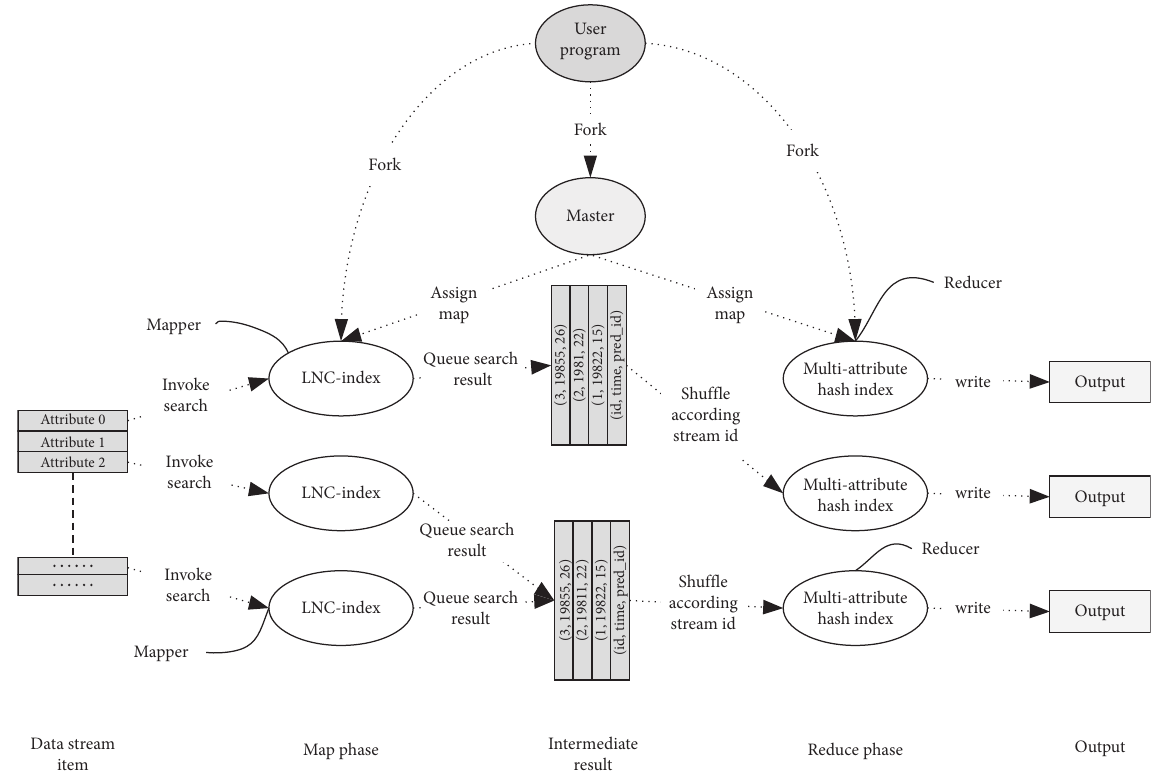
Figure 2: Online execution of cloud stream querying. We divide the querying of coming stream item into two phases: Map phase and Reduce phase. For every coming stream item, we first divide the item into key/value pairs according to the attributes. Then, in the Map phase, we dispatch key/value pairs to different LCN-Indexes to search the satisfied predicates. All these intermediate satisfied predicates are shuffled to Reducer according the stream ID. Last, in the Reduce phase, we use efficient algorithm to merge all intermediate results to compute all satisfied queries and